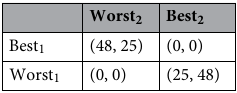
Table 2. Battle of the sexes